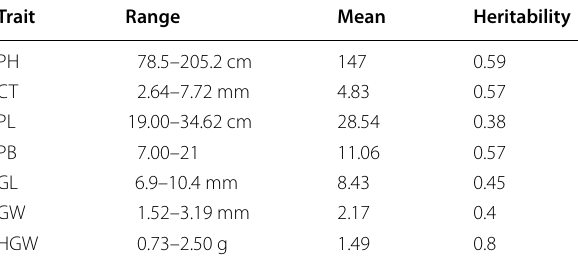
Table 1 Basic statistical summary of phenotypic data